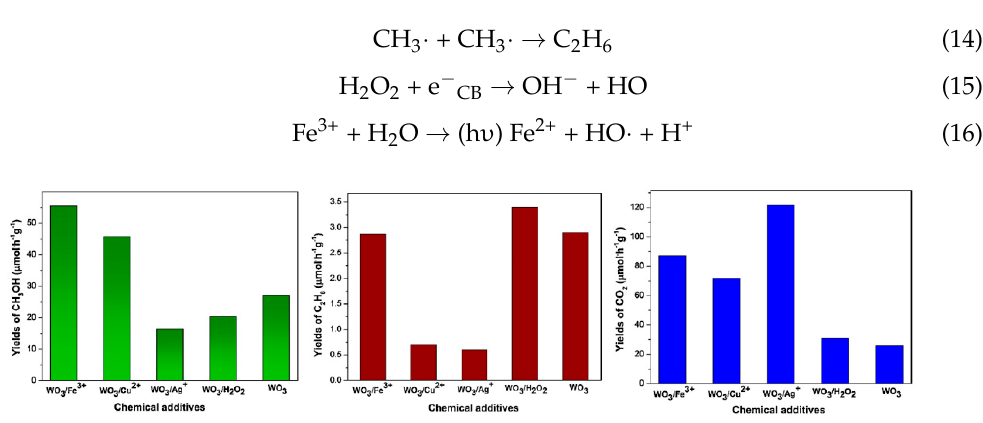
Figure 43. Yields of ( a ) methanol, ( b ) ethane, and ( c ) CO 2 using various oxidants and WO 3 as a photocatalyst. Copyright (2015), reprinted from [57] with permission from Elsevier.